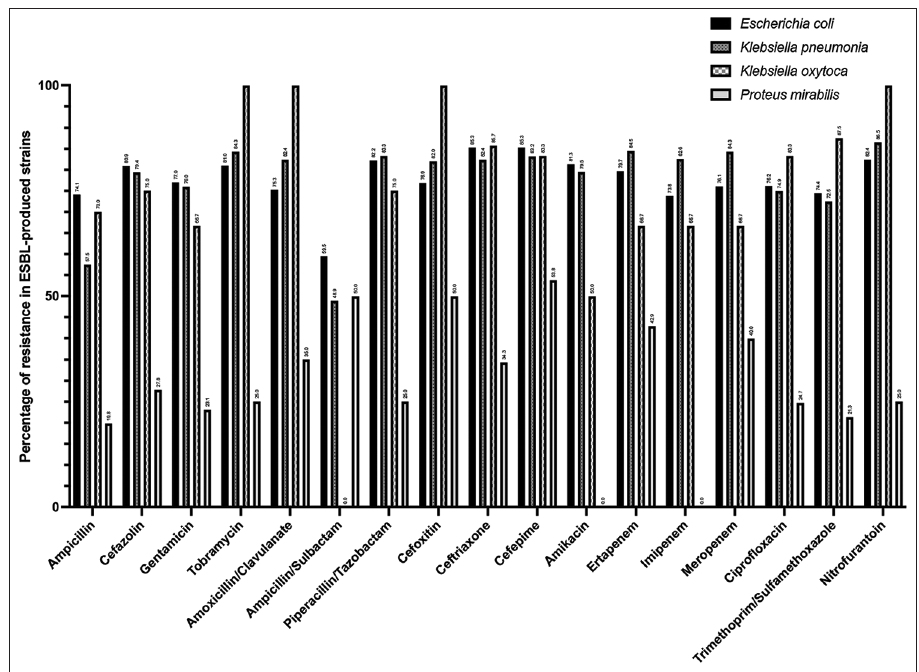
FIGURE 2. Antibiotic resistance rate among Extended Spectrum Beta‑Lactamase‑producing bacterium TABLE 3. Percentage of 4 types of Enterobacteriaceae strains isolated